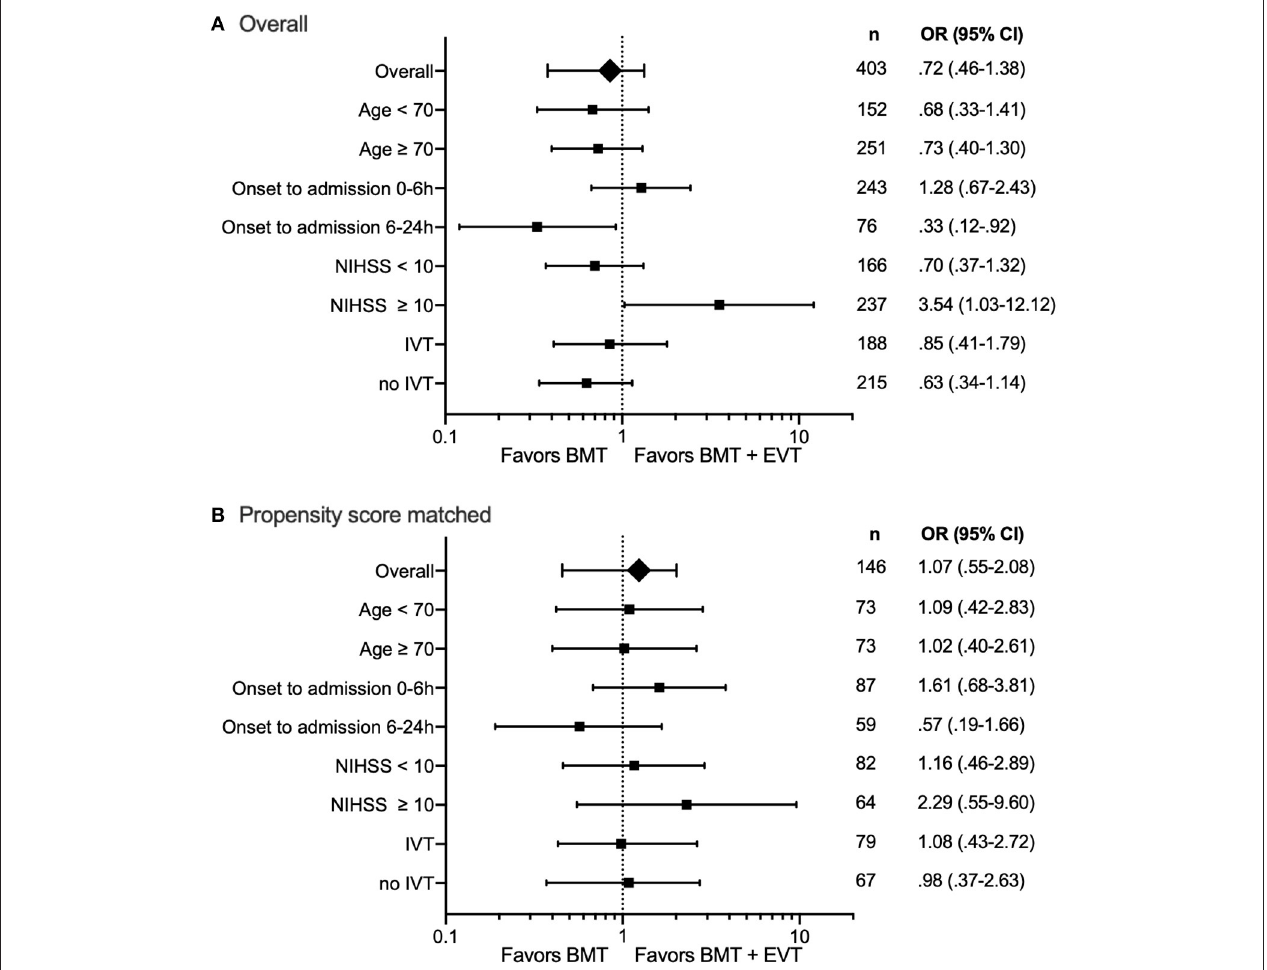
FIGURE 2 | Forest plot of additional endovascular therapy (EVT) on favorable outcome (mRS 0–3) at discharge from hospital. (A) includes all patients ( n = 403). (B) Propensity Score matched data set ( n = 146) for age, care situation prior to admission (independent at home, care at home, and care in institution), mRS at admission, baseline NIHSS, and medical history, such as diabetes mellitus, arterial hypertension, prior stroke, and time from onset to admission < 24h. Number of patients and odds ratio (OR) with 95% CI are